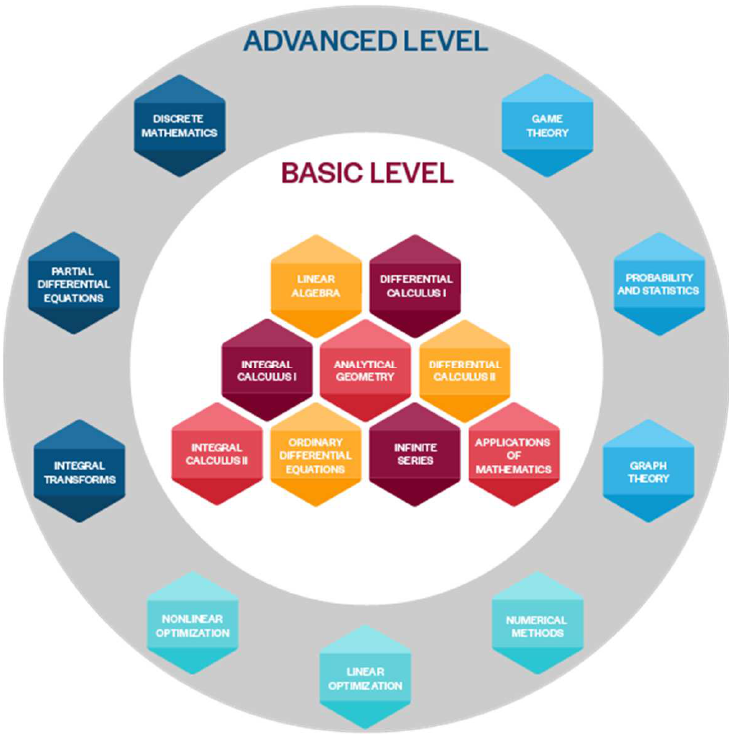
Figure 1. Modular approach to splitting mathematical content.